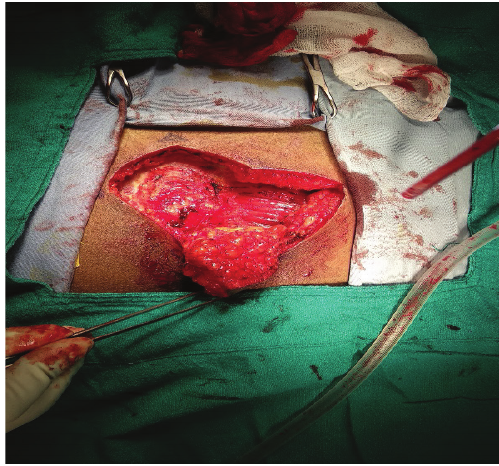
Figure 3: The flap is raised